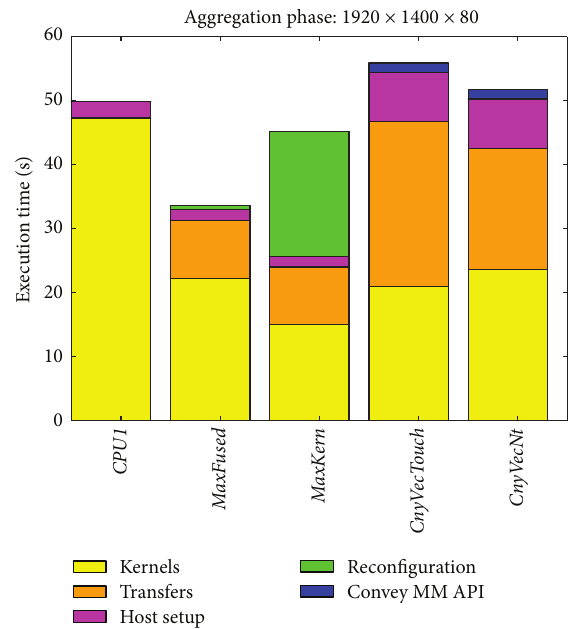
Figure 16: Breakdown of individual runtime components inside aggregation